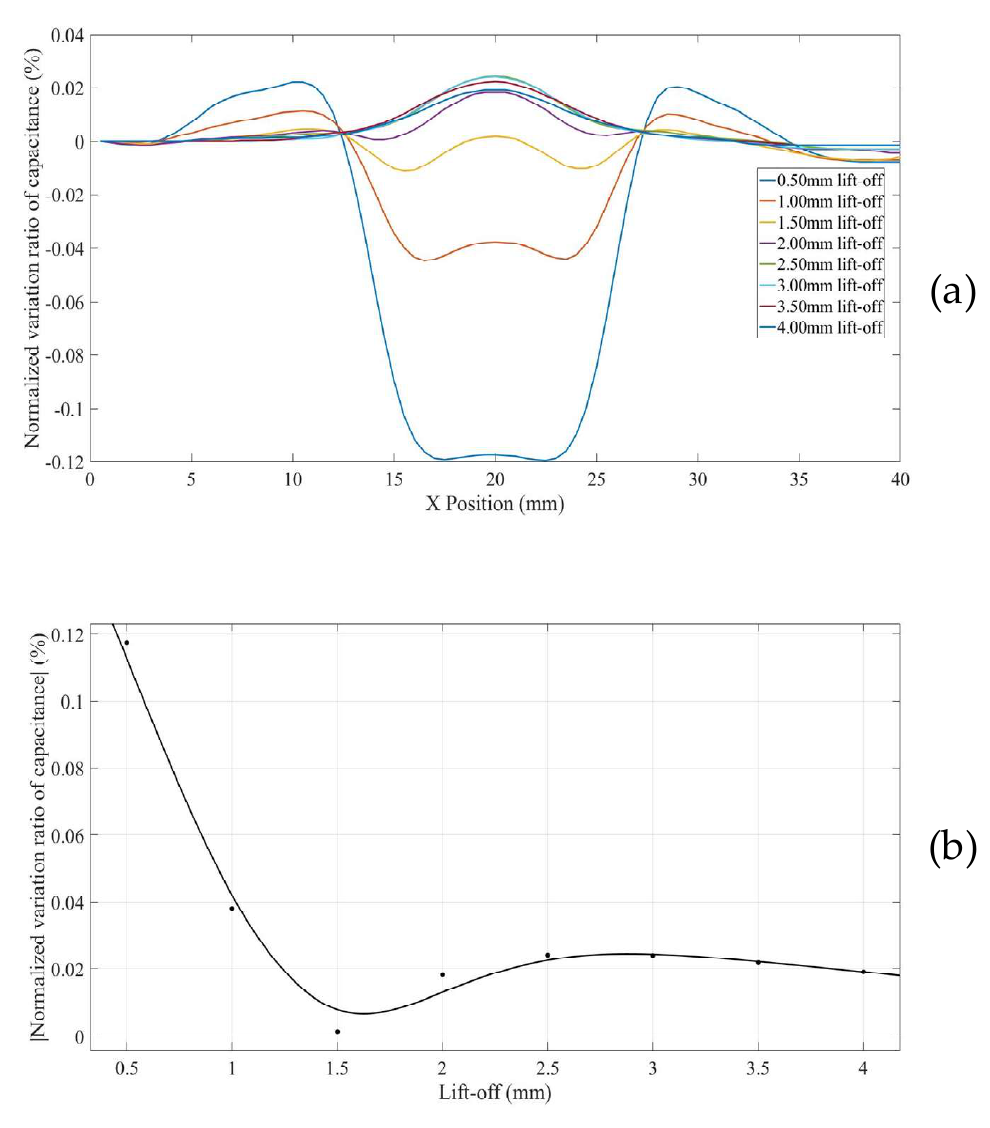
Figure 18. ( a ) NVR curves for the through hole on specimen I (placed on grounded conducting plate) with lift-offs increased from 0.5 mm to 4 mm ( b ) absolute values of the NVRs at the centre point against lift-offs.